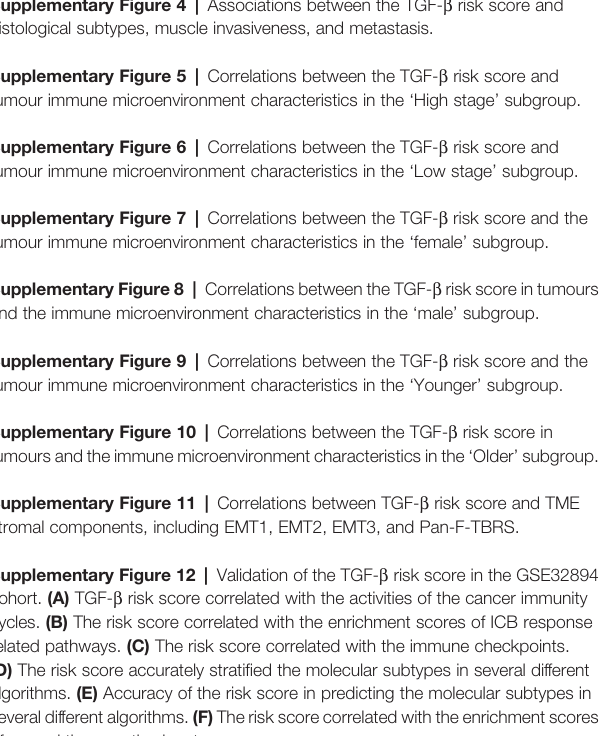
Supplementary Figure 4 | Associations between the TGF- b risk score and histological subtypes, muscle invasiveness, and metastasis. Supplementary Figure 5 | Correlations between the TGF- b risk score and tumour immune microenvironment characteristics in the ‘ High stage ’ subgroup. Supplementary Figure 6 | Correlations between the TGF- b risk score and tumour immune microenvironment characteristics in the ‘ Low stage ’ subgroup. Supplementary Figure 7 | Correlations between the TGF- b risk score and the tumour immune microenvironment characteristics in the ‘ female ’ subgroup. Supplementary Figure 8 | Correlations between the TGF- b risk score in tumours and the immune microenvironment characteristics in the ‘ male ’ subgroup. Supplementary Figure 9 | Correlations between the TGF- b risk score and the tumour immune microenvironment characteristics in the ‘ Younger ’ subgroup. Supplementary Figure 10 | Correlations between the TGF- b risk score in tumours and the immune microenvironment characteristics in the ‘ Older ’ subgroup. Supplementary Figure 11 | Correlations between TGF- b risk score and TME stromal components, including EMT1, EMT2, EMT3, and Pan-F-TBRS. Supplementary Figure 12 | Validation of the TGF- b risk score in the GSE32894 cohort. (A) TGF- b risk score correlated with the activities of the cancer immunity cycles. (B) The risk score correlated with the enrichment scores of ICB response related pathways. (C) The risk score correlated with the immune checkpoints. (D) The risk score accurately strati fi ed the molecular subtypes in several different algorithms. (E) Accuracy of the risk score in predicting the molecular subtypes in several different algorithms. (F) Therisk scorecorrelated withthe enrichment scores of several therapeutic signatures. Supplementary Figure 13 | Validation of the TGF- b risk score in the GSE48075 cohort. (A) TGF- b risk score correlated with the activities of the cancer immunity cycles. (B) The risk score correlated with the enrichment scores of ICB response related pathways. (C) The risk score correlated with the immune checkpoints. (D) The risk score accurately strati fi ed the molecular subtypes in several different algorithms. (E) Accuracy of the risk score in predicting the molecular subtypes in several different algorithms. (F) Therisk scorecorrelated withthe enrichment scores of several therapeutic signatures. Supplementary Figure 14 | Associations between the TGF- b risk score and therapeutic response of immunotherapy in three cohorts. Supplementary Table 1 | TGF- b genes and detailed information of four BLCA cohorts applied in our analysis. Supplementary Table 2 | Sixty differentially expressed TGF- b genes between BLCA and normal tissues. Supplementary Table 3 | (A) Coef fi cients of 5 optimal candidate genes included in the TGF- b risk score with univariate Cox regression analysis. (B) Coef fi cients of 5 optimal candidate genes included in the TGF- b risk score algorithm. Supplementary Table 4 | Correlations between the risk score and the in fi ltration levels of TIICs in six independent algorithms. Supplementary Table 5 | Correlations between the risk score and immune